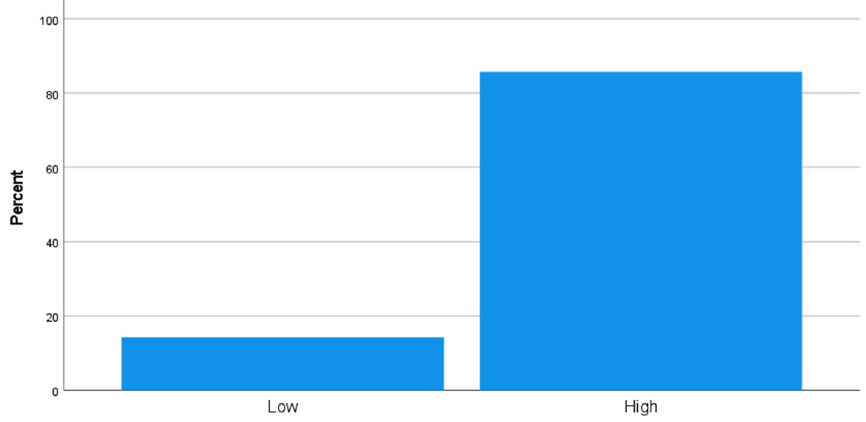
Fig. 8 Based on the previous question, choose either High or Low to describe your organization survivability. Source Author